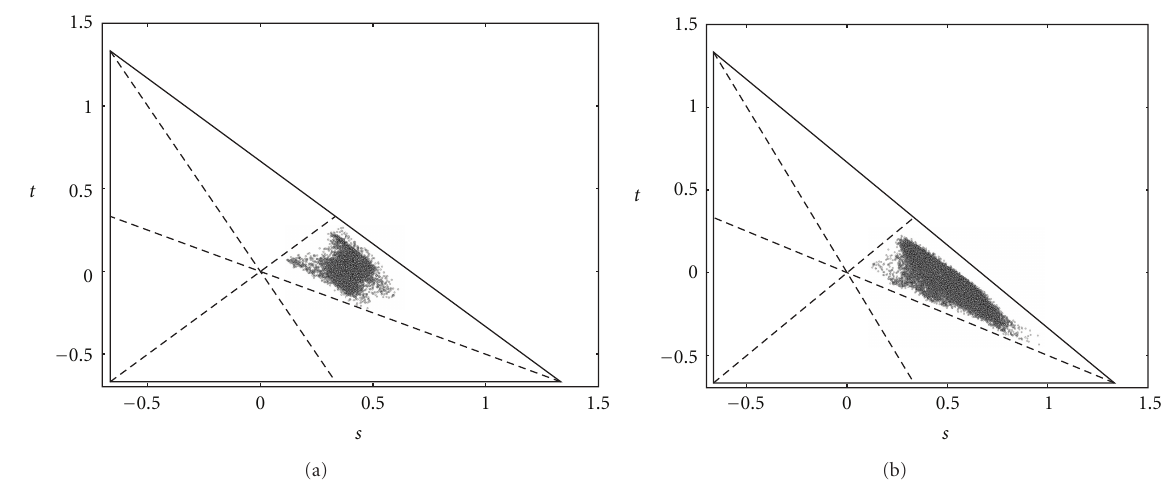
Figure 11: Values of ( s , t ) in the Lumley triangle for the forced (a) and the free vortex zone (b). Table 3: Comparison of CFD r ∗ c value with Nagata’s and Le Lan’s models (Re a = 7 10 4